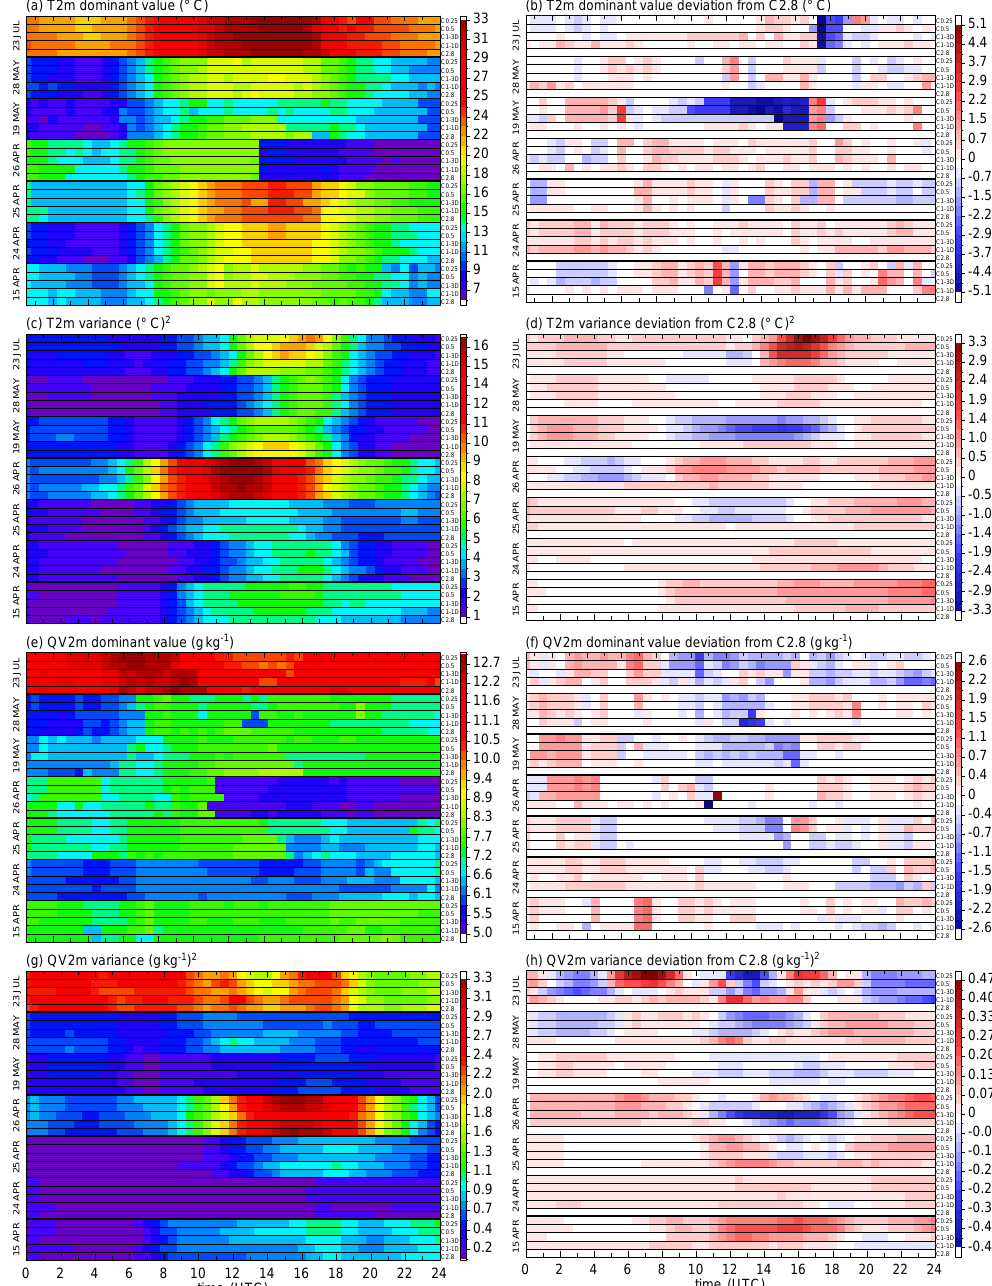
Figure 14. Dominant value (a, e) and variance (c, g) as well as their deviations from the reference run (b, d, f, h) of the PDFs of 2m temperature (T2m) and specific humidity (QV2m) as a function of time for all cases analyzed. Each row represents the values of one model realization for the entire 24h period in steps of